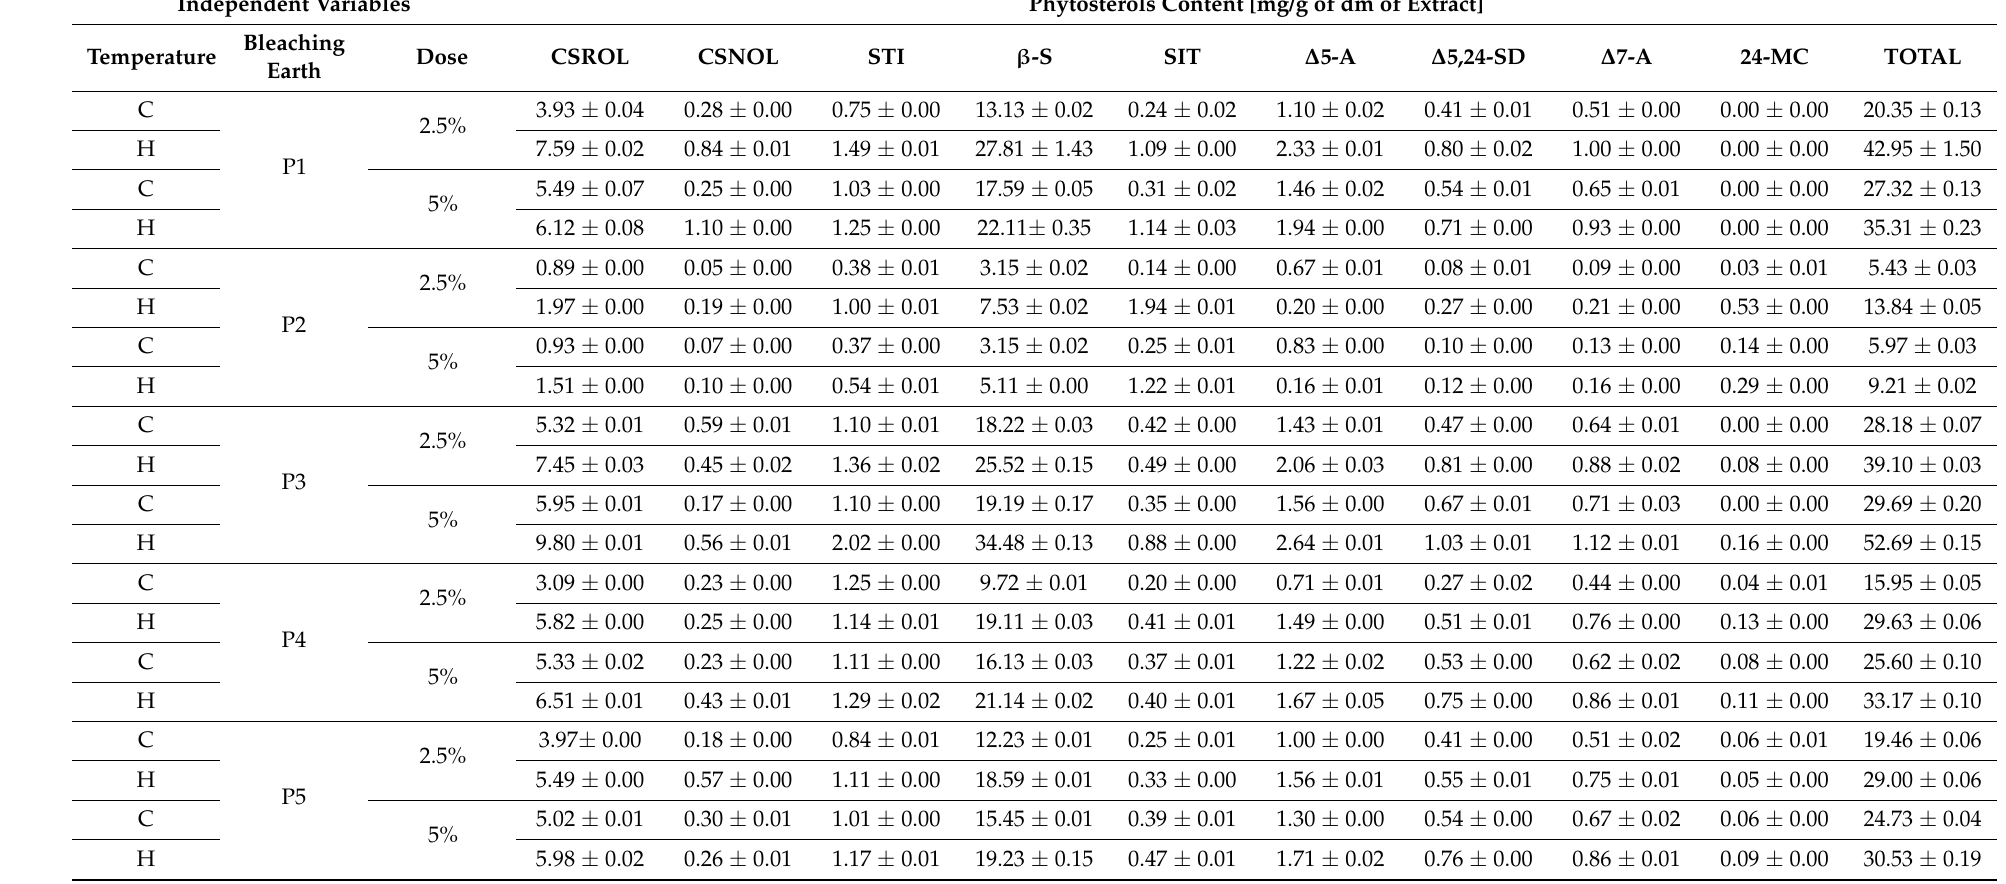
Table A2. The content of phytosterols in the poraffin extracts formed after washing bleaching earth with methanol bleaching earth after bleaching oil from the ‘Earline’ variety. Mean values based on n =